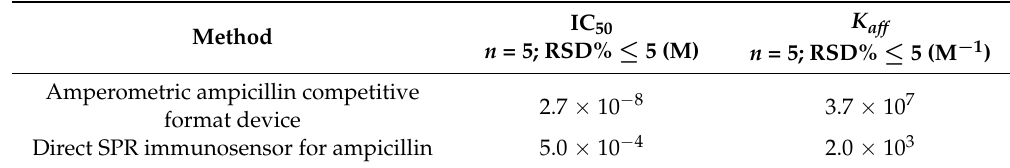
Table 2. IC 50 and k aff values for the ampicillin obtained by the SPR immunosensor, and the values found using the conventional amperometric immunosensor.